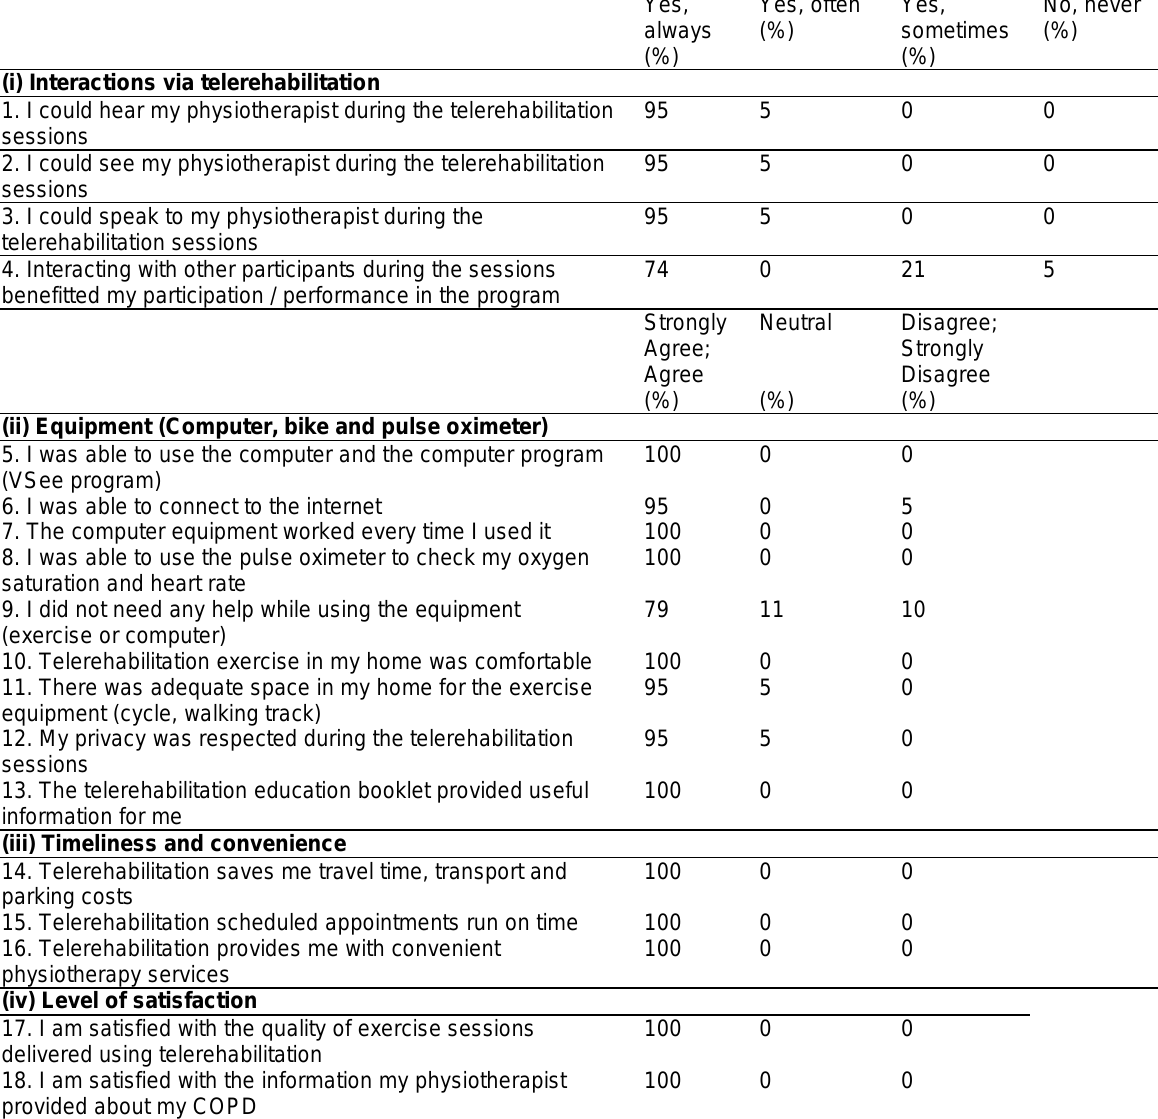
Table 2 Results of Participant Satisfaction Survey